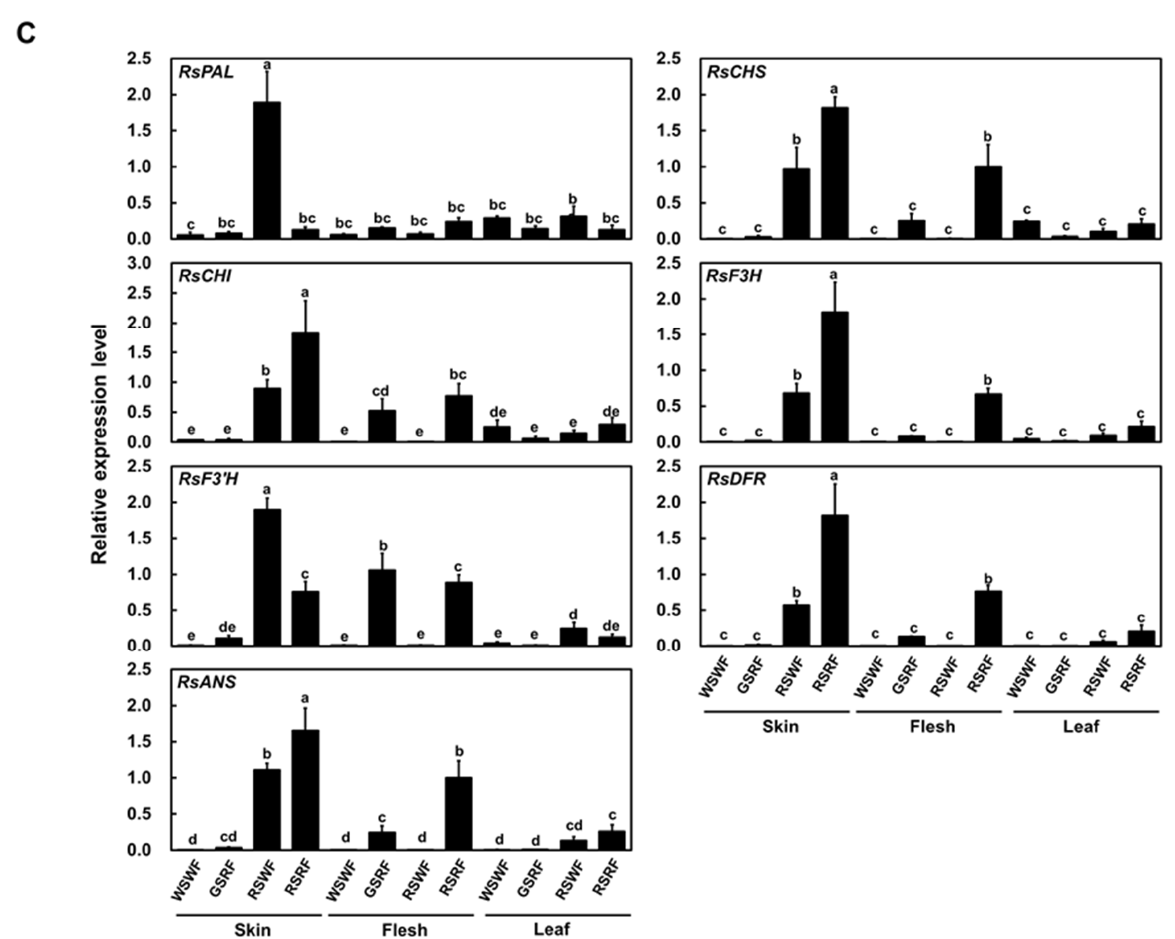
Figure 2. Expression of RsTTG1 and other anthocyanin regulatory and biosynthesis genes in various radish cultivars with different pigmentation patterns. ( A ) Visual phenotypes of the four radish cultivars at the mature stage, with whole taproots on the left and sectioned taproots showing their flesh color on the right of each image. WSWF: white skin and white flesh; GSRF: green skin and red flesh; RSWF: red skin and white flesh; RSRF: red skin and red flesh. ( B ) Relative transcript levels of anthocyanin biosynthesis regulators. ( C ) Relative transcript levels of anthocyanin biosynthesis genes. Results are means ± SD from three independent biological replicates. RsRPII was used as the internal reference gene. Different letters indicate significantly different values ( p < 0.05), as determined using a two-way ANOVA followed by Duncan’s multiple range tests.